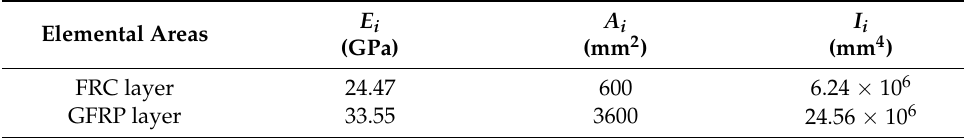
Table 12. Parameters used to determine the shear stiffness of the cross-section. Elemental Areas